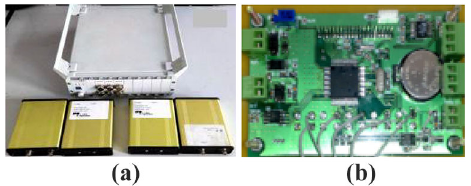
Fig. 4 Charge signal monitoring system. a Preamplifier and acqui- sition instrument, b Circuit board